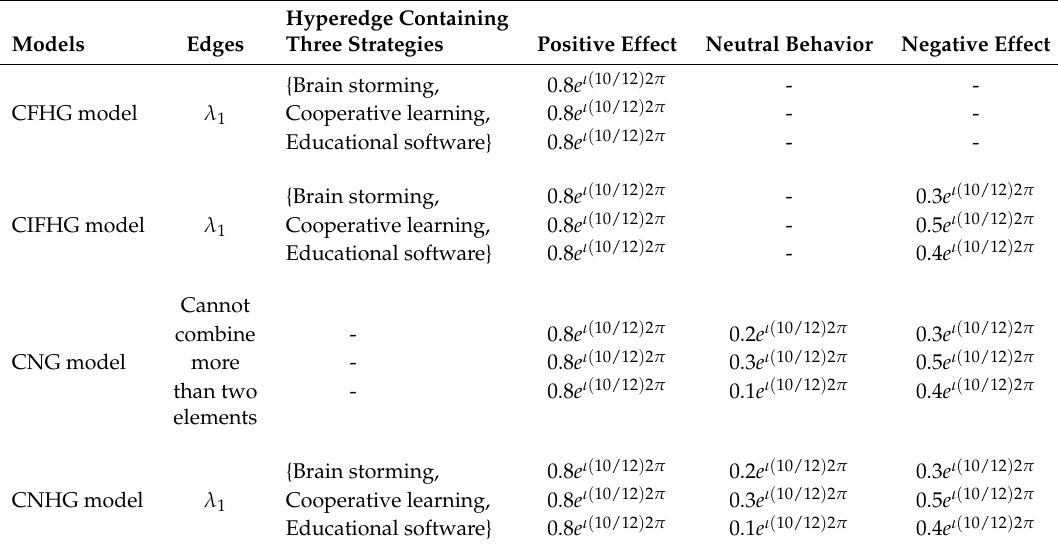
Table 7. Comparative